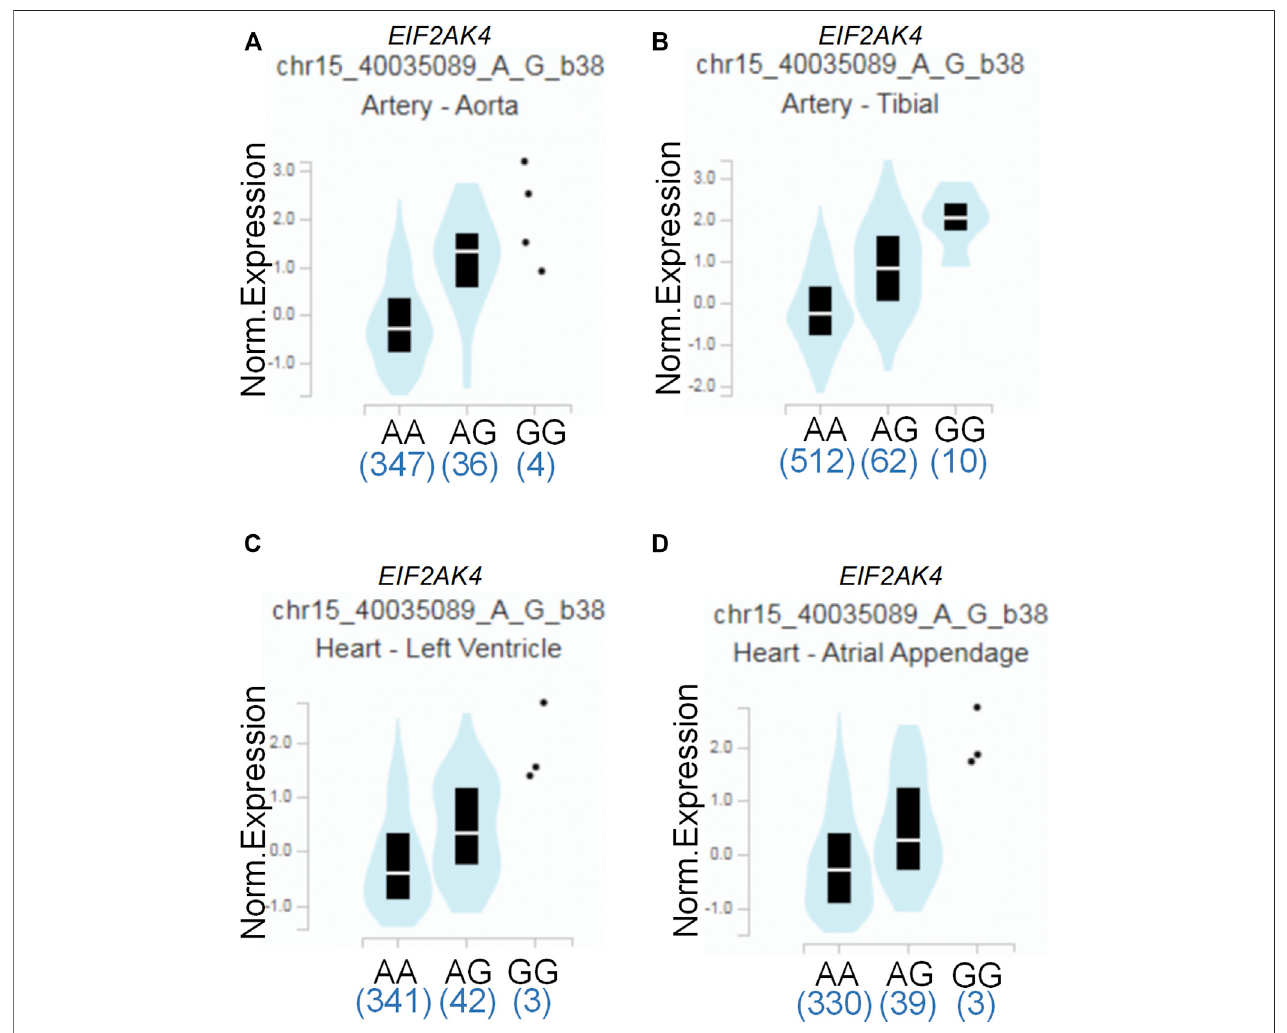
FIGURE1| Functionalimplicationofthe EIF2AK4 geners4594236polymorphisminhumantissues. (A) Thegenotypeofrs4594236andexpressionofthe EIF2AK4 geneinthearteryoftheaortaweresearchedonthepublicdatabaseGTExPortal. p =2.6×10 − 20 . (B) Thegenotypeofrs4594236andexpressionofthe EIF2AK4 genein the artery ofthetibia weresearchedon thepublic database GTEx Portal. p =2.4×10 − 18 . (C) Thegenotype ofrs4594236andexpression ofthe EIF2AK4 geneintheleft ventricleoftheheartweresearchedonthepublicdatabaseGTExPortal. p =3.4×10 − 8 . (D) Thegenotypeofrs4594236andexpressionofthe EIF2AK4 geneinthe atrial appendage of the heart were searched on the public database GTEx Portal. p = 2.1 × 10 − 8 .